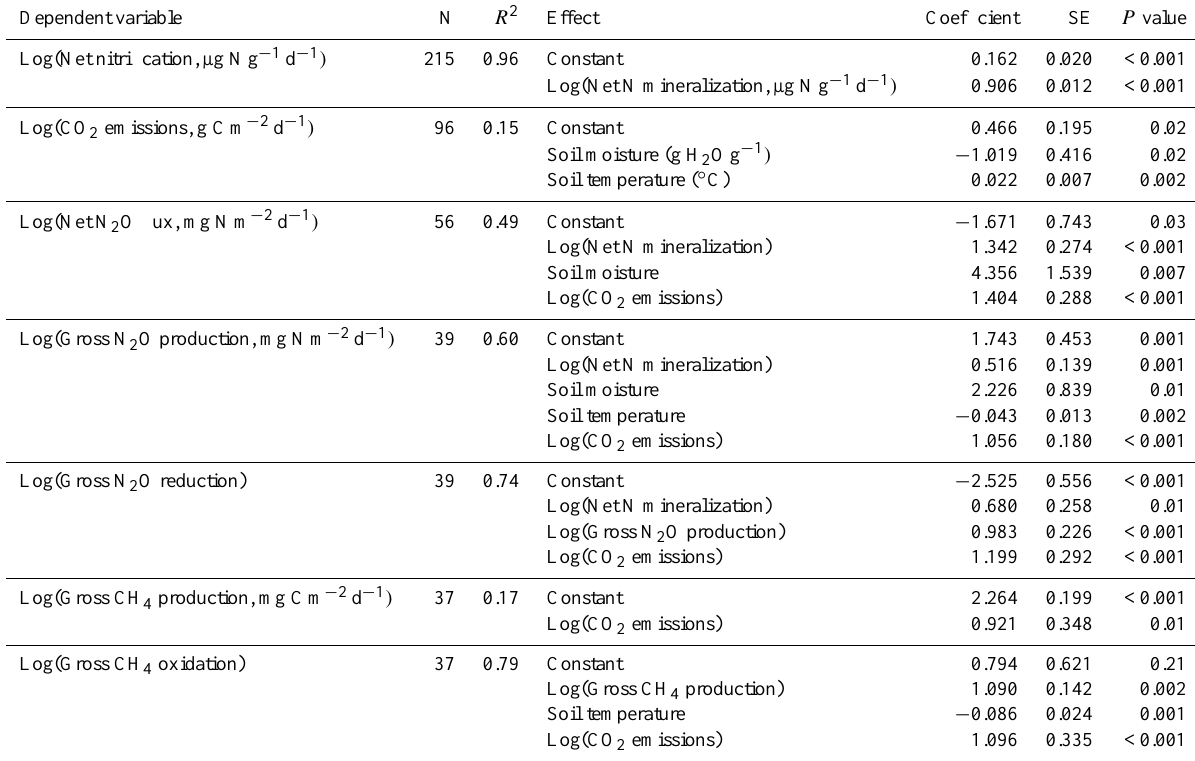
Table 4. Coefficients for multiple linear regressions predicting trace gas fluxes using soil